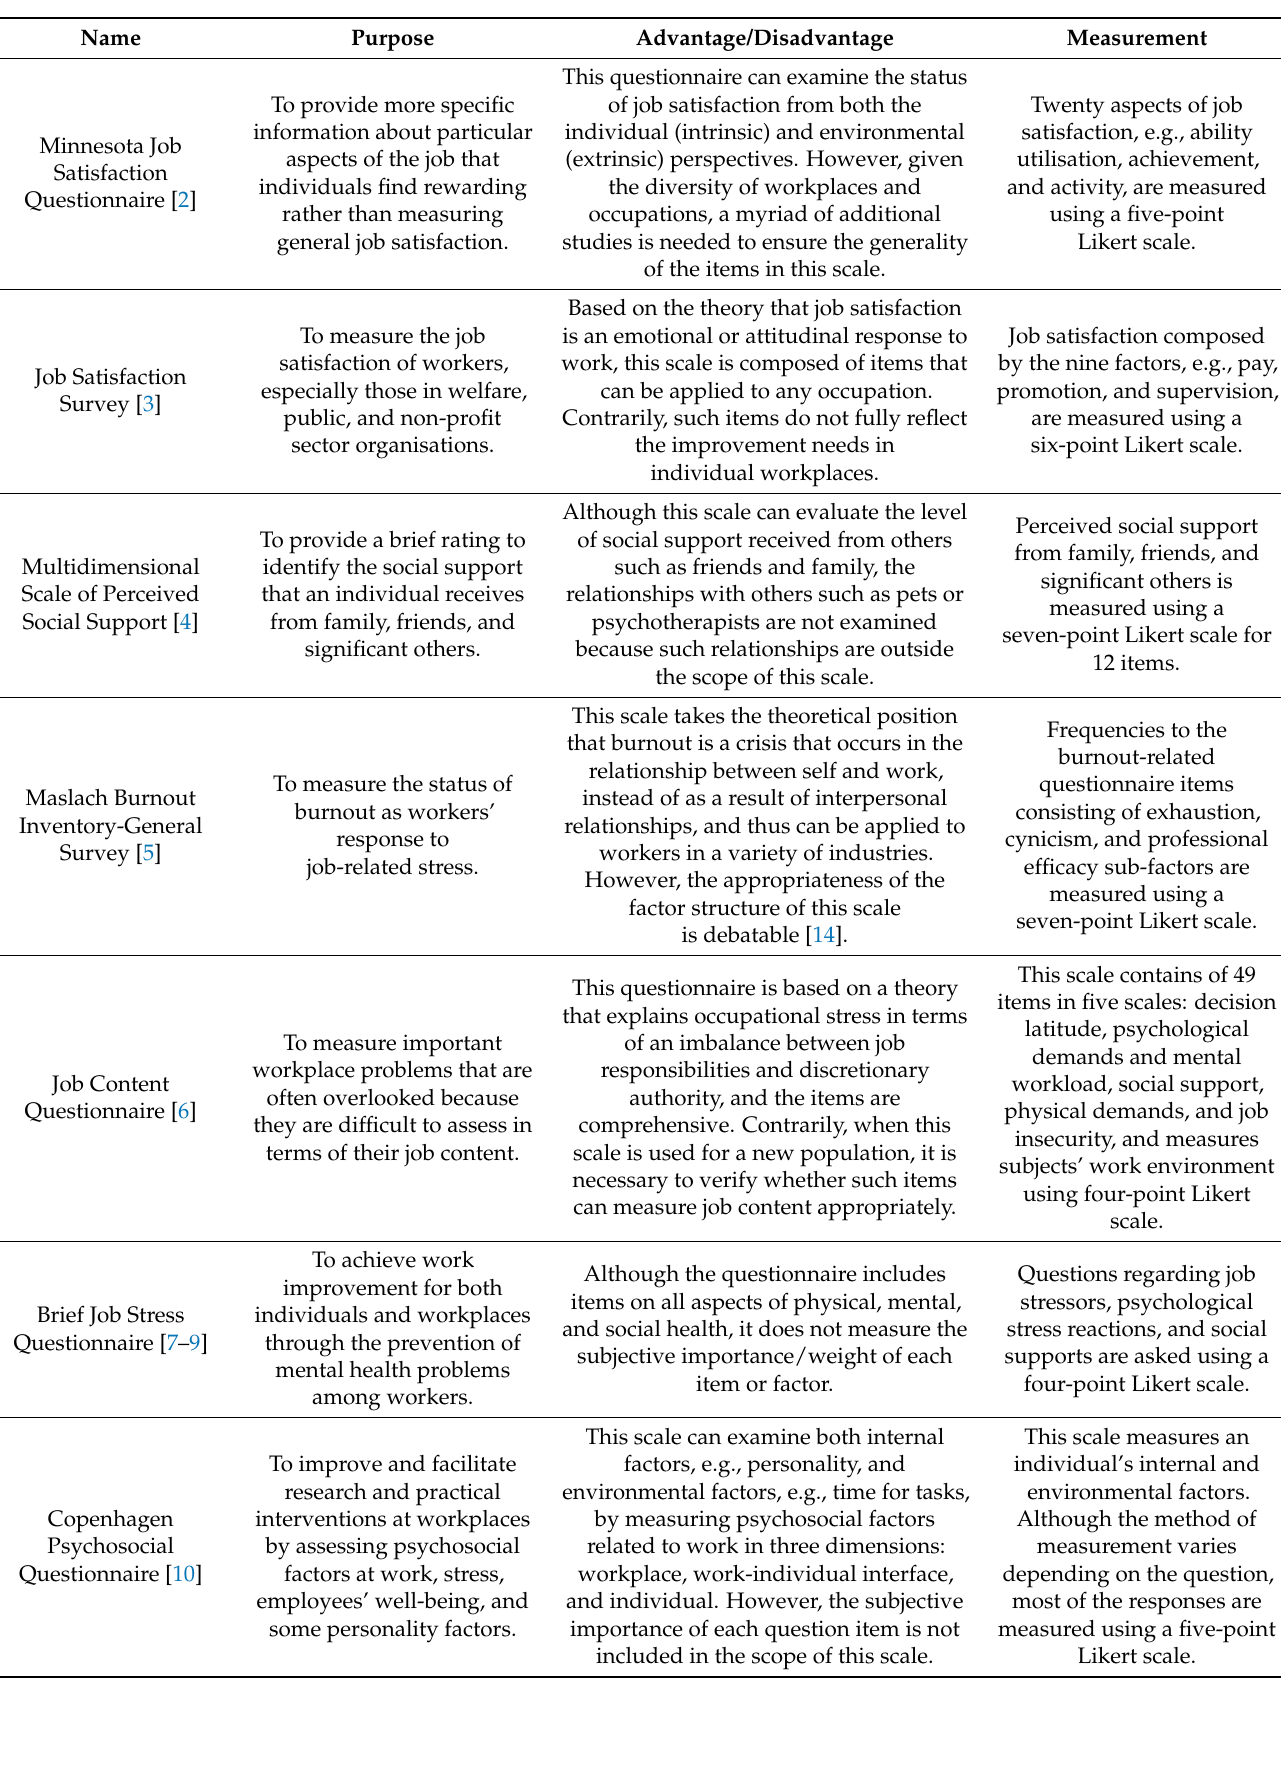
Table 1. Examples of psychological scales/instruments to enhance decent